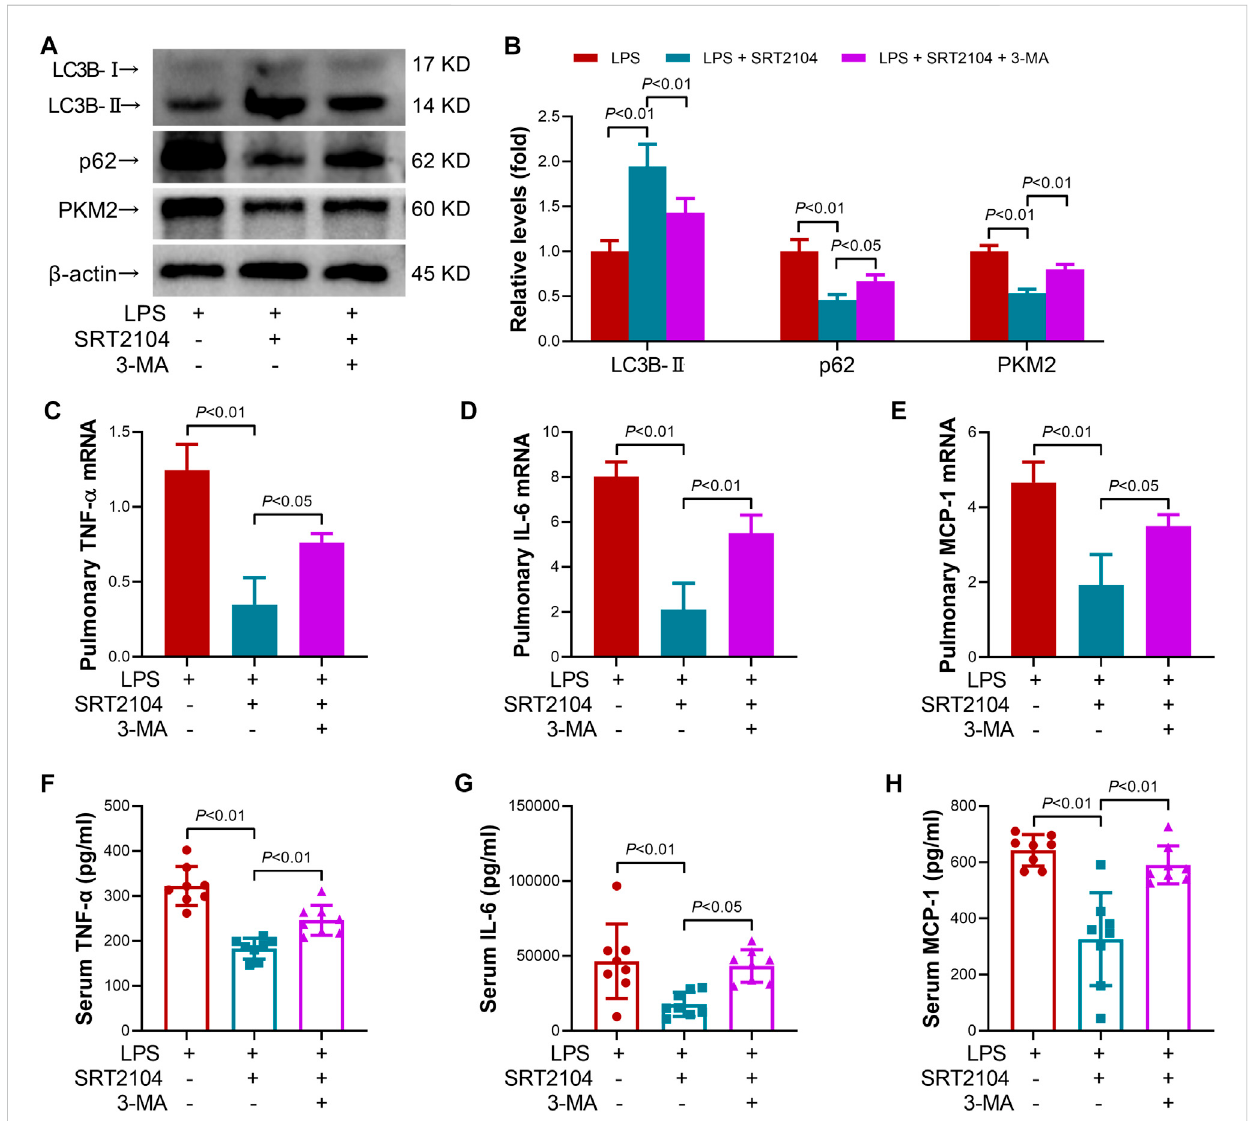
FIGURE 4 Autophagy inhibitor 3-MA reversed the suppressive effects of SRT2104 on PKM2 and in fl ammation. C57BL/6 mice were challenged with LPS to induce systemic in fl ammation, vehicle or SRT2104 (25 mg/kg) was injected intraperitoneally with or without 3-MA (15 mg/kg) co-administration. The mice were sacri fi ced 8 h post LPS exposure, and the lung samples as well as serum samples were collected. (A,B) The protein levels of LC3B-II, p62 and PKM2 in lung tissues were determined, n = 4. (C – E) The mRNA levels of (C) TNF- α , (D) IL-6 and (E) MCP-1 in lung tissues were determined, n = 3. (F – H) The serum levels of (F) TNF- α , (G) IL-6 and (H) MCP-1 were determined, n = 8. Data were expressed as means